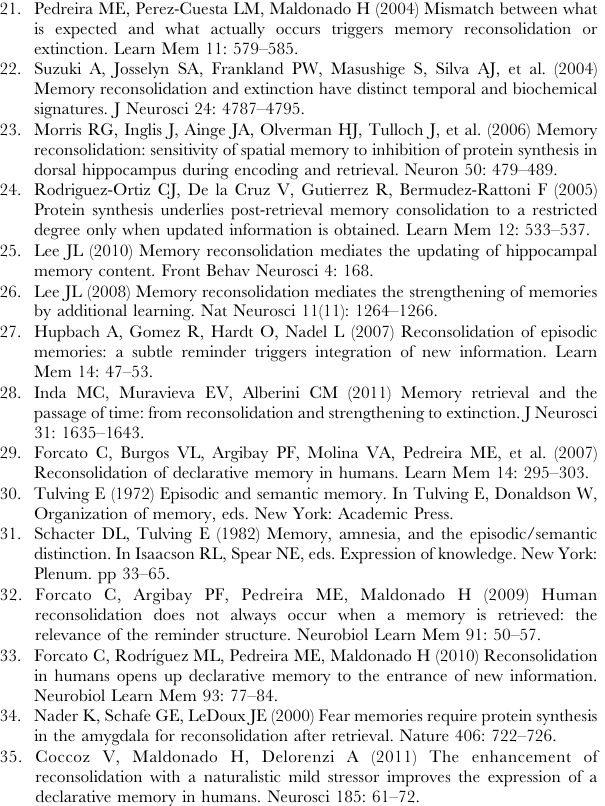
bar for the Group R c x4. B) Experiment 1B. Black dots stand for the Group R c , grey triangles stand for the Group no-R, Inset. Mean number of total errors in the four last actual trials. Black bar stands for Group R c , grey bar for Group no-R. C) Experiment 2. Black dots stand for the Group R c , grey triangles stand for the Group R c- r x2, Inset. Mean number of total errors in the four last actual trials. Black bar stands for Group R c , grey bar for Group R c-r x2. D) Experiment 3. Black dots stand for the Group R c -ST, grey squares stand for the Group R c x2-ST, Inset. Mean number of total errors in the four last actual trials. Black bar stands for Group R c -ST, grey bar for Group R c x2-ST. E) Experiment 4. Black dots stand for the Group R c , grey squares stand for the Group R c x2-24h, Inset. Mean number of total errors in the four last actual trials. Black bar stands for Group R c , grey bar for Group R c x2-24h. F) Experiment 5. White triangles stand for the Group R c x2, white dots stand for the Group R c x2-2h, grey squares for the Group R c R ctx -2h. Inset. Mean number of total errors in the four last actual trials. White bar stands for Group R c x2, striped bar for Group R c x2-2h and grey bar for the Group R c R ctx -2h.